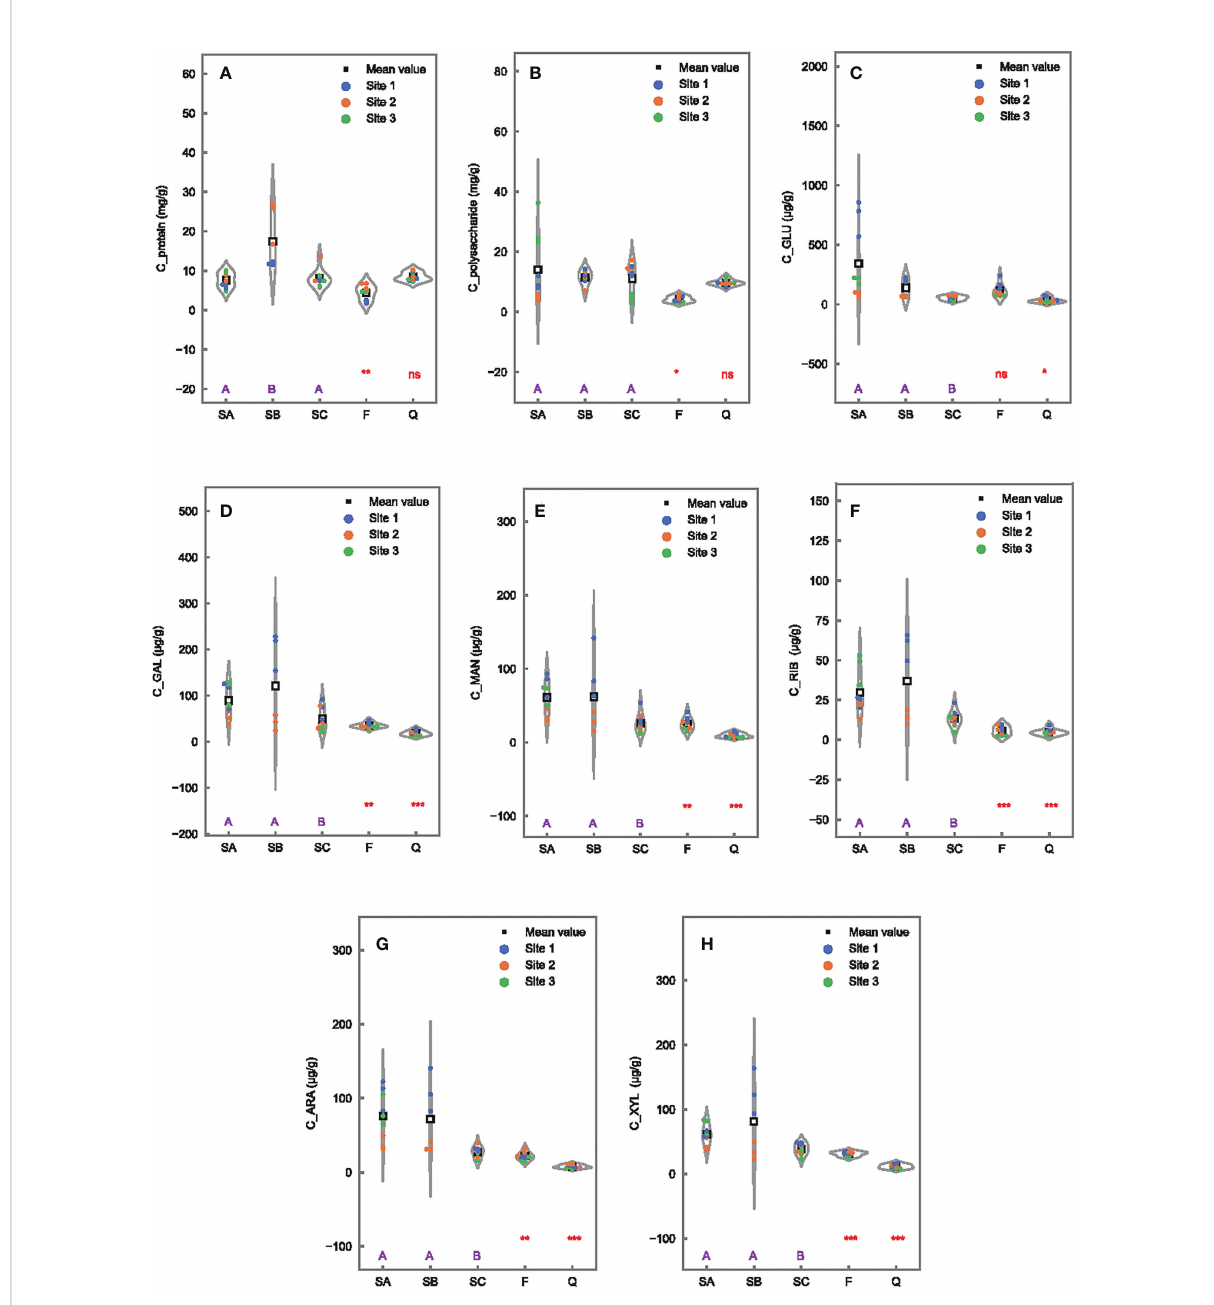
FIGURE 5 Differences of EPS constituents in colloidal fraction in 0- to 1-cm surface sediments among tidal levels in Futian (SA, SB, and SC), between sampling times (SA vs. F), and between Futian and Qi ’ ao wetlands (SA vs. Q). Different letter shows signi fi cant differences among tidal levels at p < 0.05 according to one-way ANOVA, while *, **, and *** indicate signi fi cant differences between times, as well as between mangrove wetlands at p < 0.05, 0.01, and 0.001, respectively, ns indicates not signi fi cant difference, according to Student ’ s t -test: (A) C_protein;